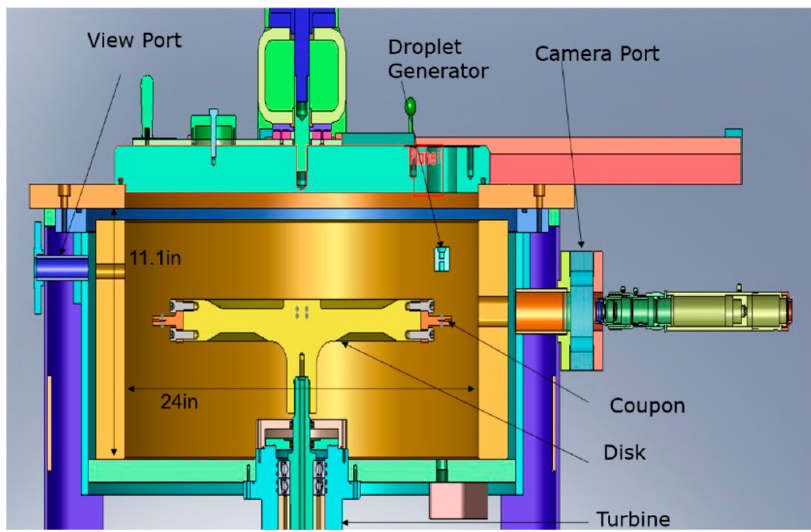
Figure 15. Example of Rotating Disc Erosion Test Rig.